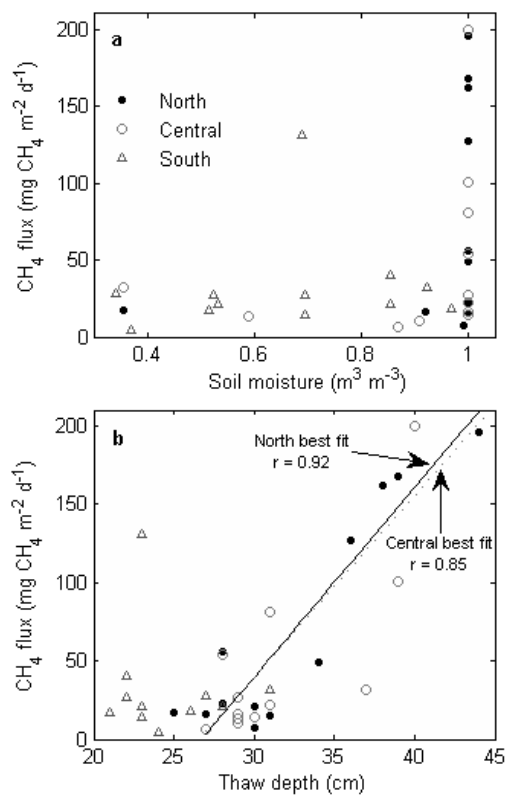
Fig. 8. Relationship between chamber measurements of CH 4 flux and soil moisture (a) and thaw depth (b) taken between 13 and 18 September 2007. Note that in this year, the South section showed a much lower water table than the North and Central sections during the growing season. Lines in (b) show the best fit between CH 4 flux and thaw depth for sites with water tables at or above the surface (only in the North and Central sections).